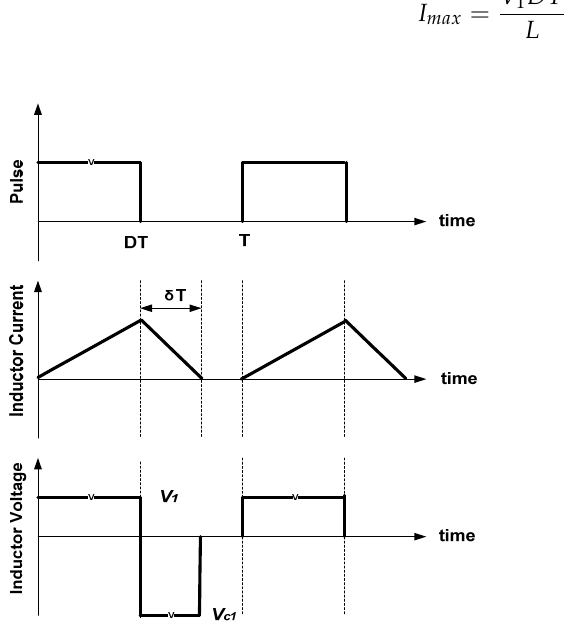
Figure 5. Schematic diagram showing the inductor current and voltage across it with pulse variation